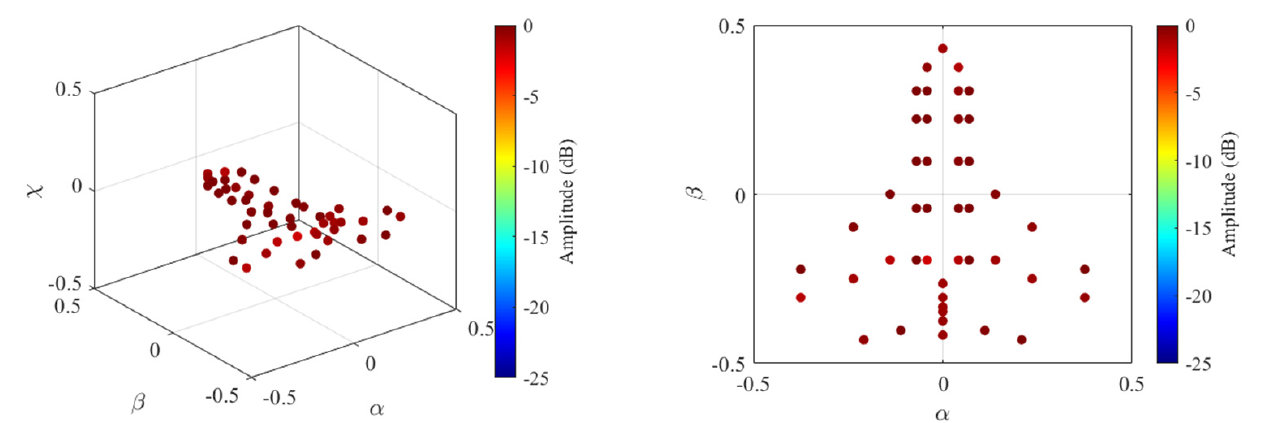
Figure 14. Target imaging result obtained by TSL0 after WDR with ISR = 70 dB. Compared to Figure 10, the target-scattering centers are more clearly separated, indicating the higher imaging resolution obtained by TSL0 than 3D IFFT.